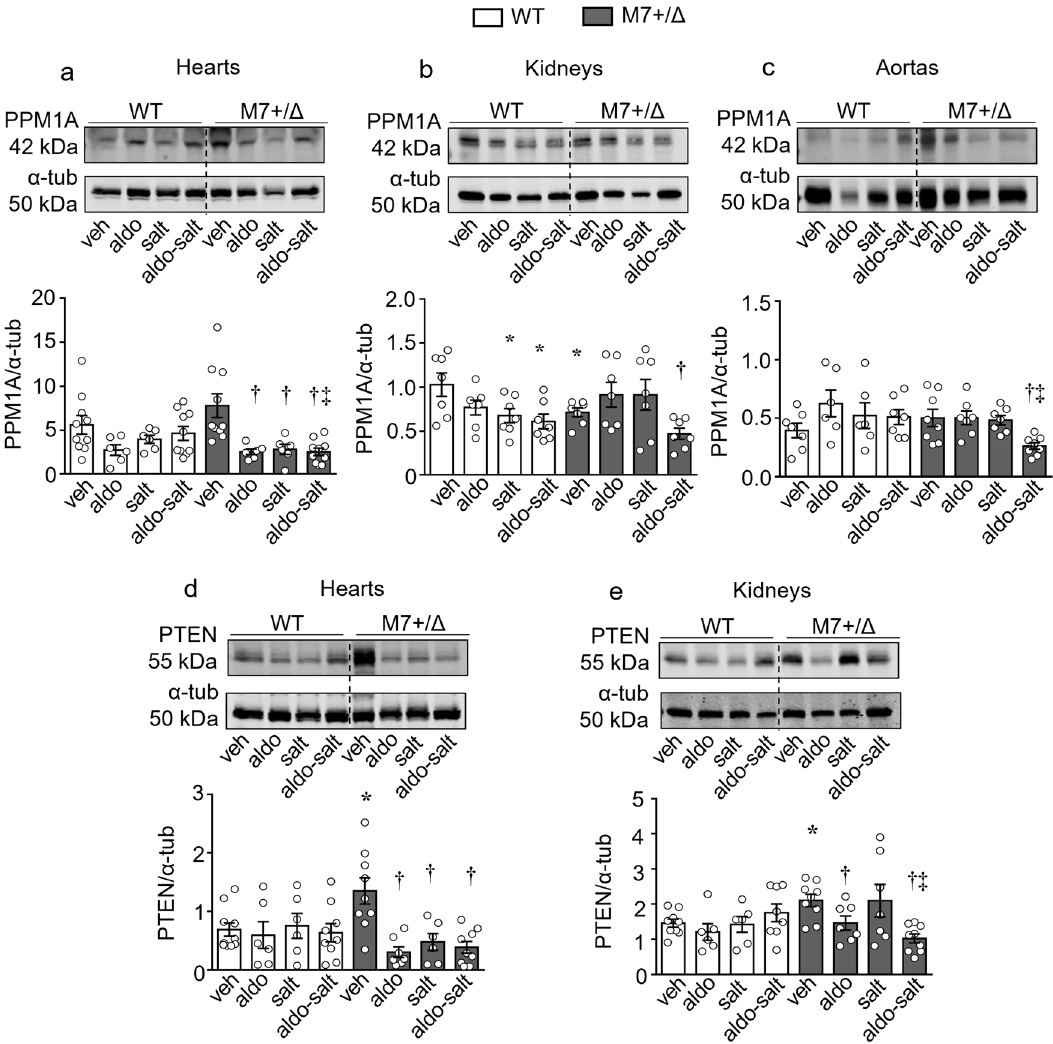
Fig. 5 TRPM7 de fi ciency is associated with reduced expression of the phosphatases PPM1A and PTEN. Tissues from mice WT (white bars) and TRPM7 + / Δ kinase (gray bars, M7 + / Δ ) were investigated for the expression of PPM1A in a hearts ( n = 6 – 10/group), b kidneys ( n = 7/group), and c aortas ( n = 6 – 8/group). PTEN expression was investigated in d hearts ( n = 6 – 10/group) and e kidneys (6 – 9/group). Protein expression was normalized to α - tubulin. Data are expressed as mean ± SEM and representative fi gures. One-way ANOVA followed by Dunnett ’ s multiple comparisons test were used